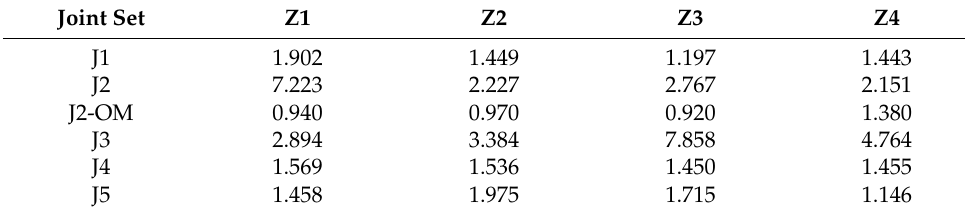
Figure 8. Normal spacing value distributions of discontinuity planes by joint set and source zone. Table 3. Joint set normal mean spacings in the different source